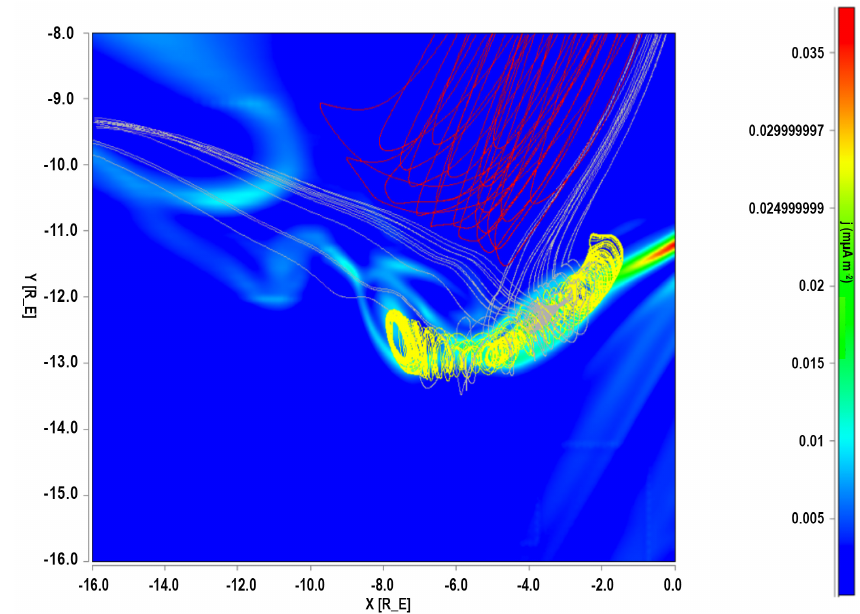
Figure 6. Close-up view of a flux transfer event in the MHD simulation at 02:23UTC (centered at X = − 3 . 5 R E and Y = − 13 R E ) seen in Fig. 2b. The color lines represent the magnetic field lines, with red being closed magnetic field lines, gray being “open” field lines (which are magnetic field lines connected on one side to Earth and on the other side to the solar wind), and yellow lines being those magnetic field lines of the IMF in the solar wind. This 2-D display shows the connectivity of the magnetic field lines of the flux transfer event.